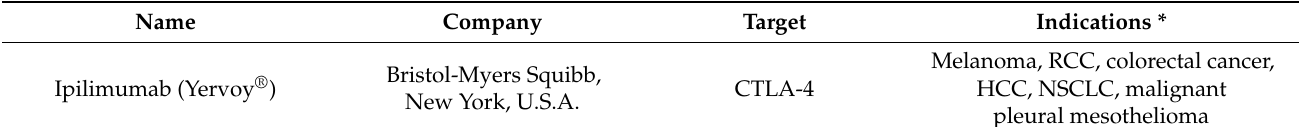
Table 1. FDA-approved immune checkpoint